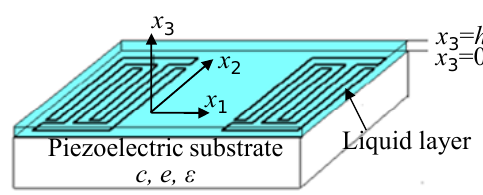
Figure 2. The coordinate system in this